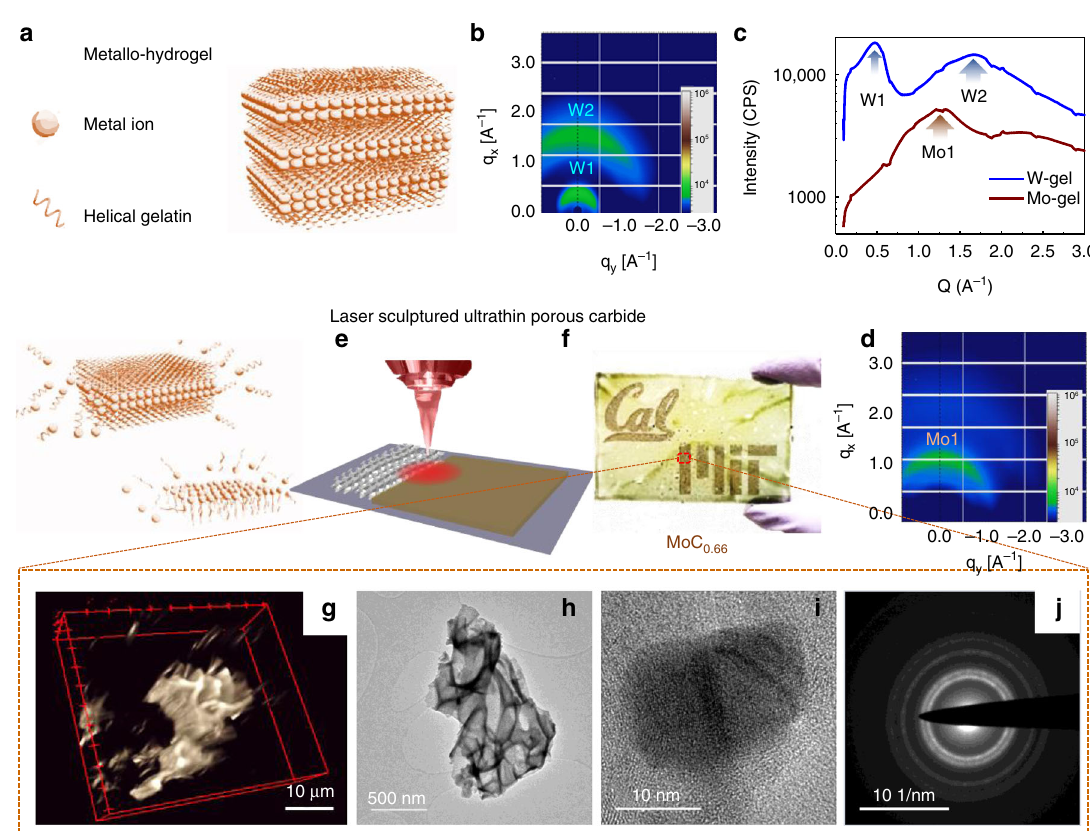
Fig. 1 Schematic of laser-sculptured ultrathin transition metal carbides. a Process for producing laser-induced transition metal carbides. Helical polymer gelatin mediated transition metal ions (metallo-hydrogel) are used to form a layer-by-layer structure. b , c Grazing incident wide angle X-ray scattering (GIWAX) characterizations of metallo-gels. b GIWAX of W-gelatin made dissolved in NMP (N-Methyl-2-pyrrolidone) 32 . c Integration of GIWAX scattering data of Mo-gel and W-gelatin-NMP. d GIWAX of Mo-gelatin template as an example to show that gelatin constrains the metal ions laterally between the layers 32 . The Mo1, W1, and W2 peaks correspond to peaks in the GIWAX scattering in b and d and show how the ion type and solvent in the template greatly affect the assembled layer distributions. e IR laser ablation generates highly porous structures with interconnected curved surfaces, for which the “ wall ” thickness reaches down to the nanometer scale. f Using the molybdenum ion as an example, carbide features of “ MIT ” and “ Cal ” are engraved on a yellowish transparent thin fi lm (~8 μ m in thickness) spin-coated onto a glass substrate with a computer aided design software. g Confocal image of 3D tomography or a selected area of laser-sculptured carbide. h TEM image of laser synthesized MoC x . i High resolution TEM images of MoC x showing the sizes of nanocrystals are around 10 nm. j Selected area diffraction of MoC x . The diffraction ring indicates a polycrystalline structure within the